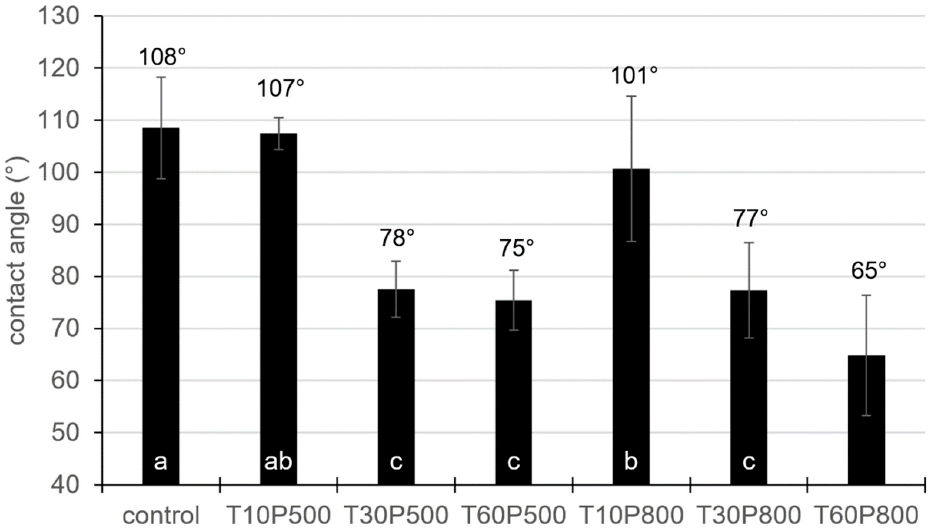
Figure 5. Effect of LPMD treatment on water contact angle on the surface of the wheat seeds (the same letter signs the variants that are not significantly different; vertical lines denote standard deviation bars).